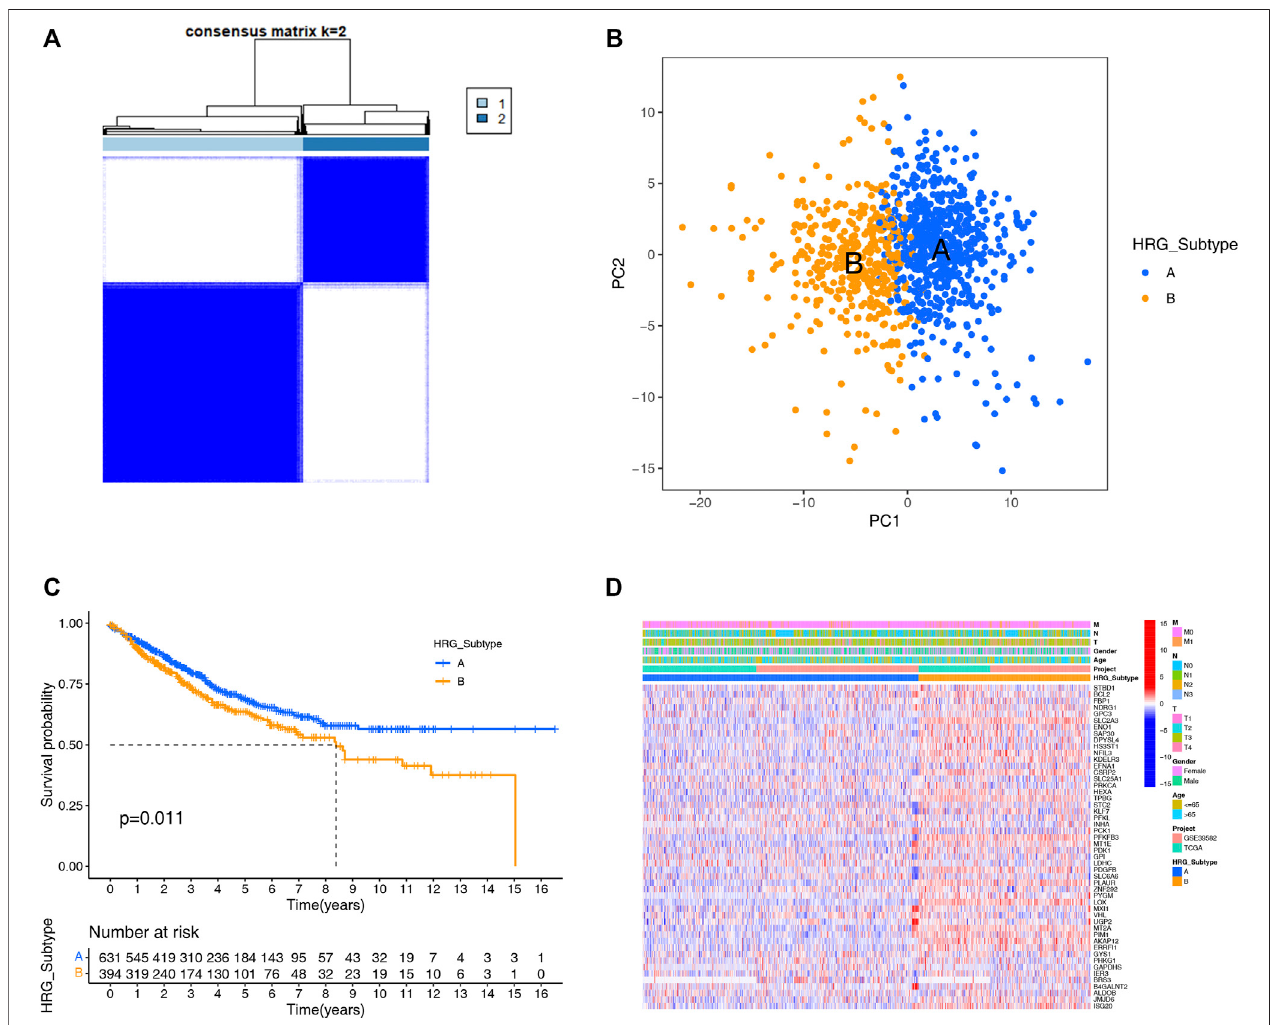
FIGURE 1 | HRG subtypes and clinical parameters and biological characteristics of two distinct subtypes of samples divided by consistent clustering. (A) Consensus matrix heatmap de fi ning two subtypes (k = 2) and their correlation area. (B) PCA showing a remarkable difference in transcriptomes between the distinct HRG-subtypes, andeach dotrepresentsasingle sample. (C) KMsurvivalcurveanalysisshowedthattheoverallsurvivaltime ofthedistinctHRG-subtypes wasdifferent (log-rank tests, p < 0.001). (D) Differences in clinical parameters and HRG expression levels between the two distinct HRG-subtypes.